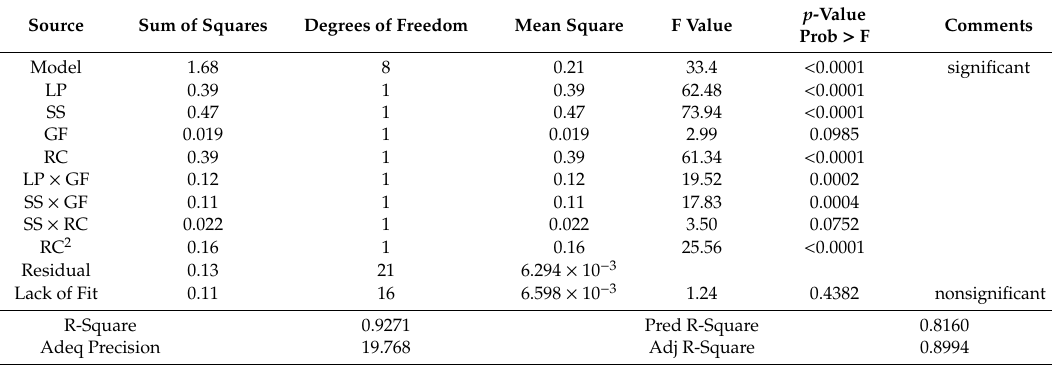
Table 4. Analysis of variance of clad width.